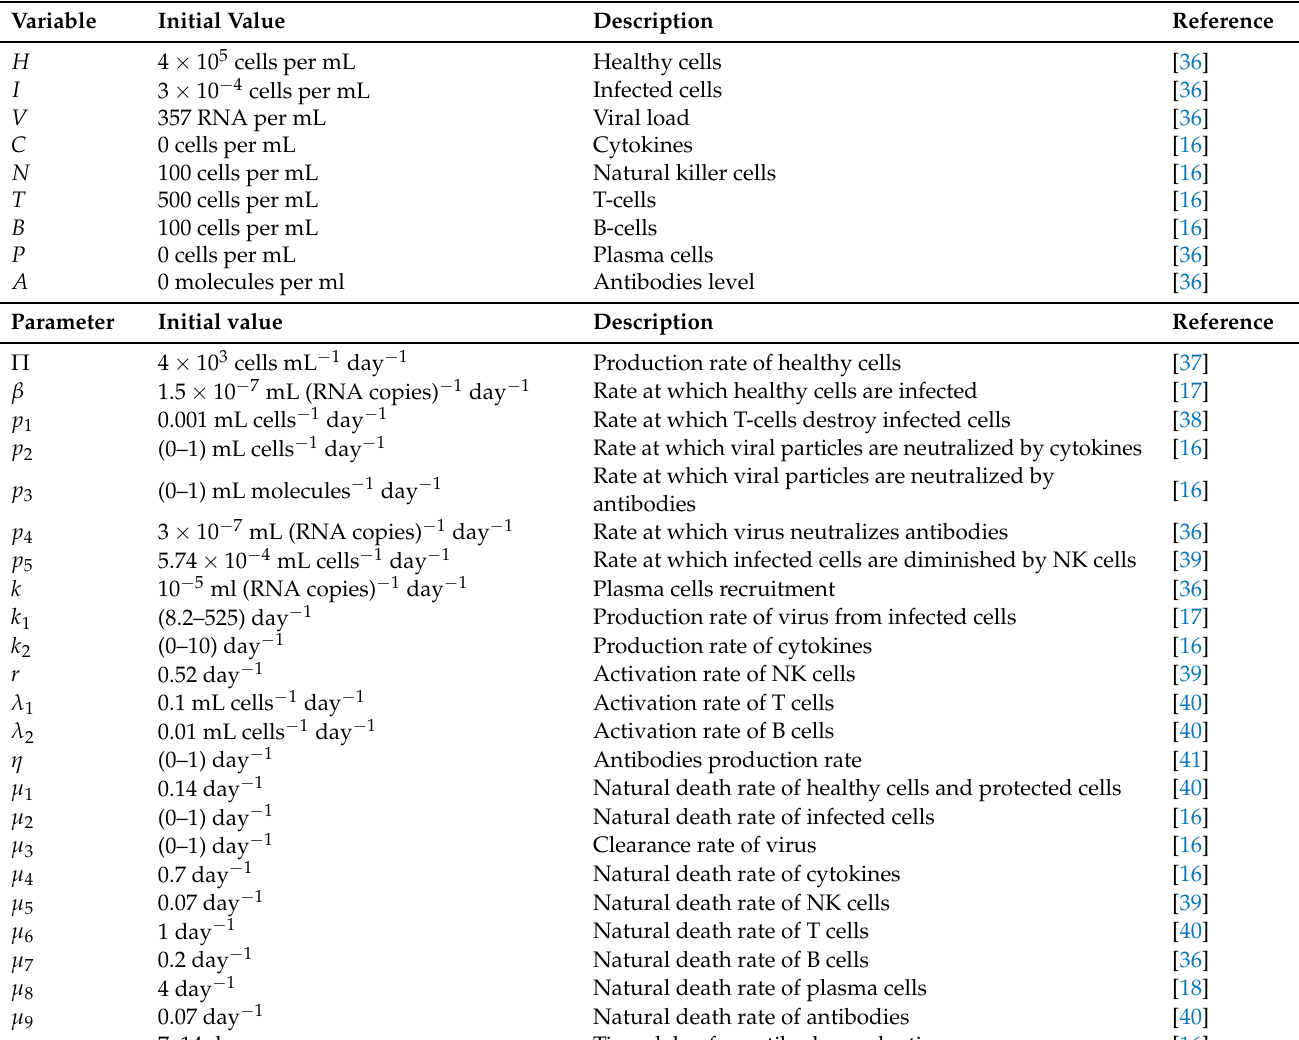
Table 1. Initial model variables and parameters and their biological